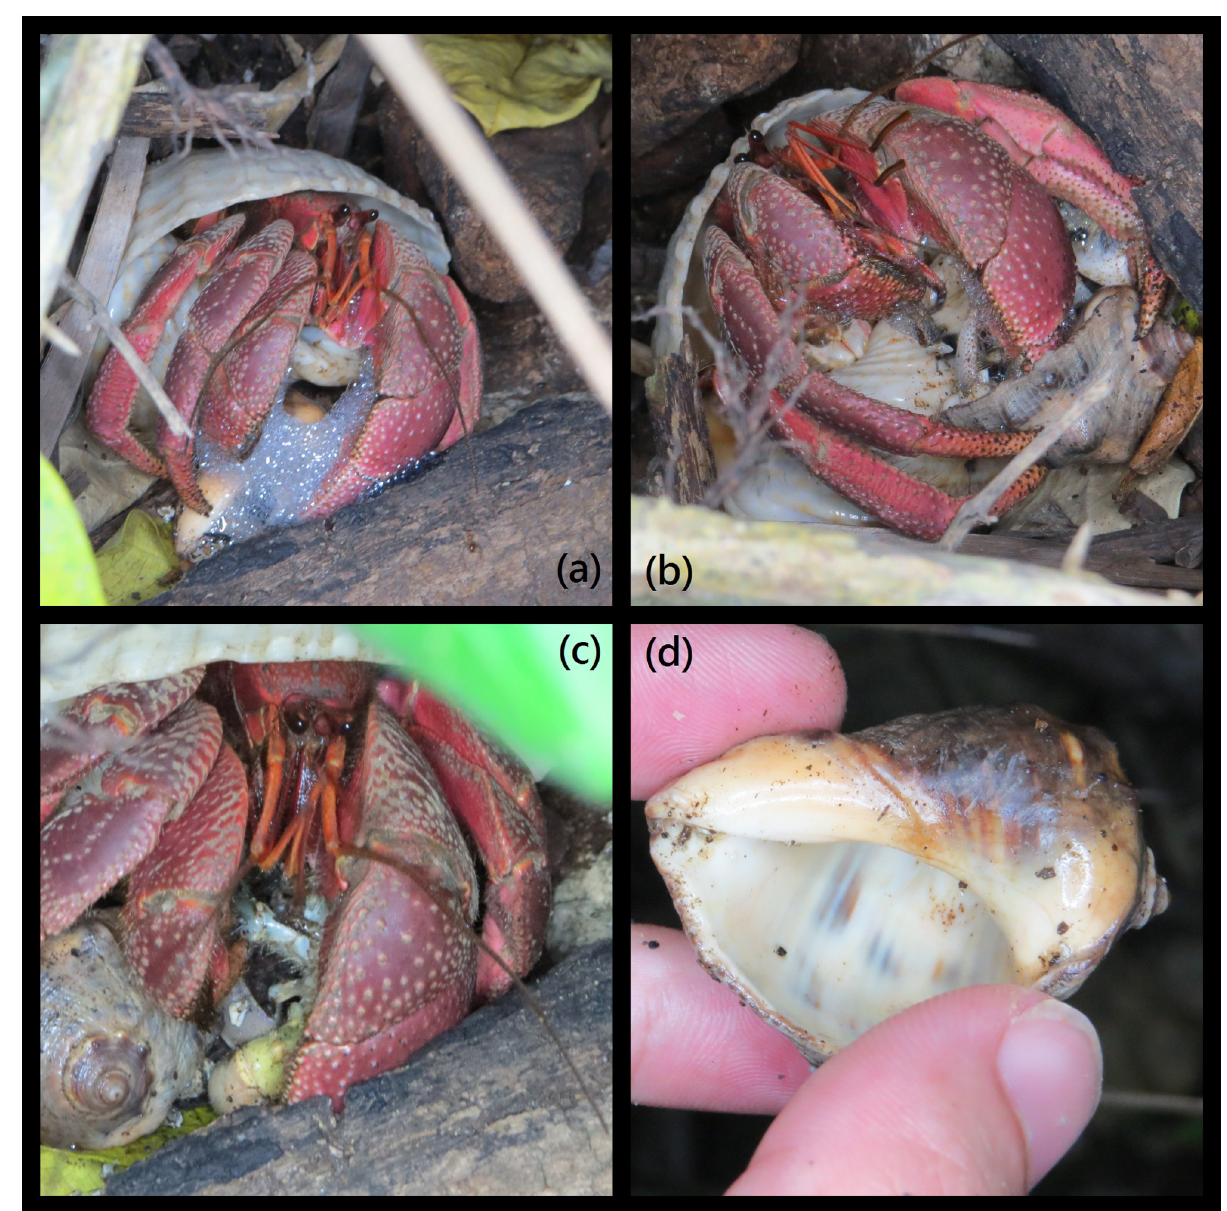
Fig 5. C . brevimanus preying on C . rugosus (in situ photograph). (a): C . brevimanus showing predatory and bubble blowing behavior; (b): Forcing C . rugosus out using the right chela; (c): C . rugosus being eaten (the abdomen is displayed); (d): Only the shell remains after one